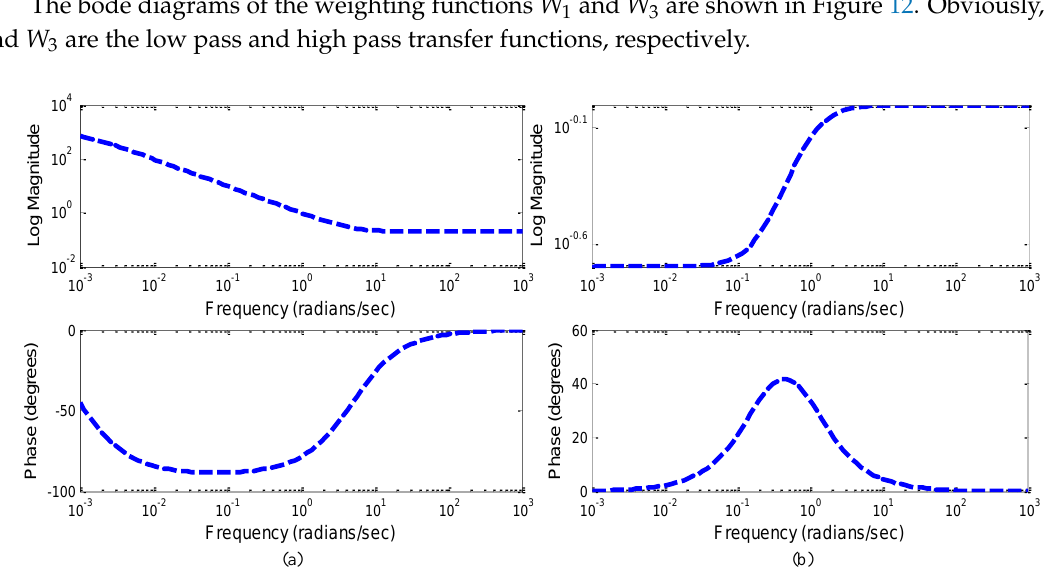
Figure 12. The bode diagrams of the weighting functions: ( a ) 𝑊 1 ; ( b ) 𝑊 3 .